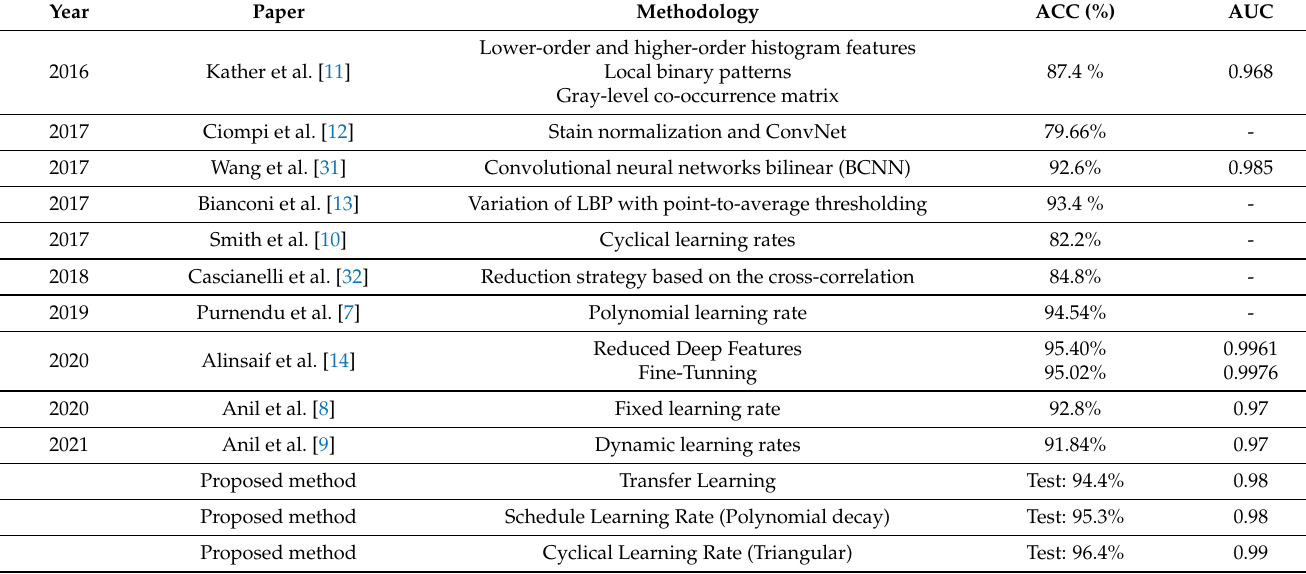
Figure 10. Results obtained by applying discriminative fine tuning with a decreasing LR in epochs. The confusion matrix, the Receiver Operating Characteristic Curve (ROC curve) and the Area Under the Curve (AUC), the confidence matrix and, in the lower right corner, the accuracy and the training loss function versus epochs are shown. In this example, a larger number of epochs has been considered to appreciate the graph. Table 5. Comparative analysis of related work available in the literature on the study of the learning rate and multi-class data-set